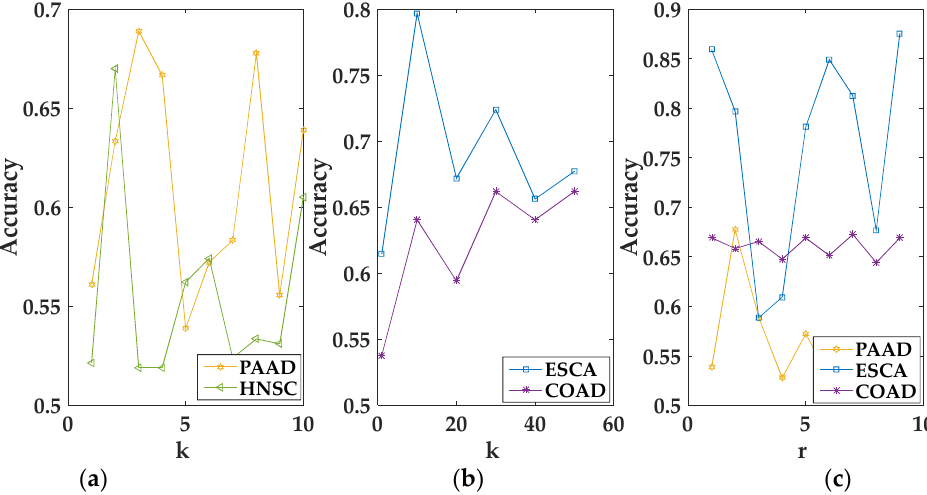
Figure 1. Performance of the Multi-view Non-negative Matrix Factorization (MvNMF) set with different values of k and r . ( a ) is the clustering performance of MvNMF on PAAD and HNSC about k ; ( b ) is the clustering performance of MvNMF on ESCA and COAD about k ; ( c ) is the clustering performance of MvNMF on PAAD, ESCA and COAD about r .